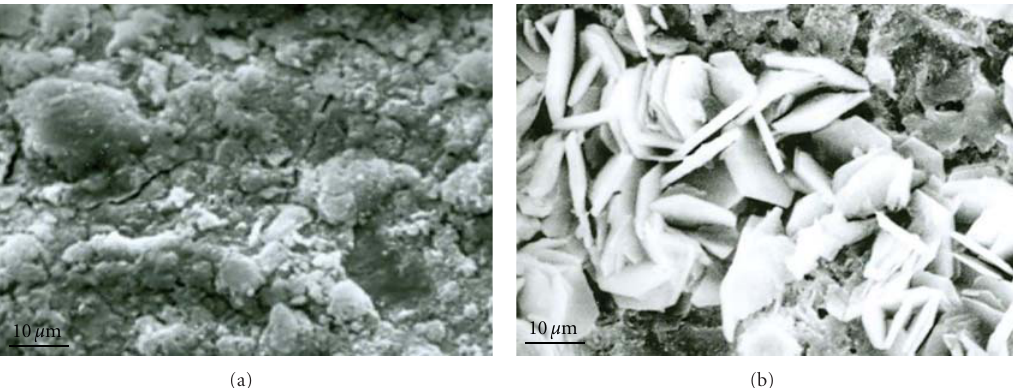
Figure 6: Morphology of corrosion product layers formed on zinc exposed in the SO 2 -polluted atmosphere of Sao Paulo (a) and marine atmosphere of Puerto Cabello